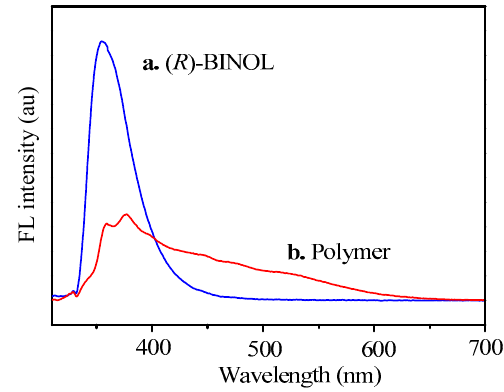
Figure 6. Emission spectra: ( a ) ( R )-BINOL in a CH 3 CN solution; ( b ) the polymeric product obtained from ( R )-BINOL in a CH 3 CN solution upon irradiation for 4.5 min ([( R )-BINOL] o = 1.0 × 10 − 6 M, cell path = 10 mm) [ λ ex 300 nm]. Intensity was normalized to a constant absorbance at 300 nm.